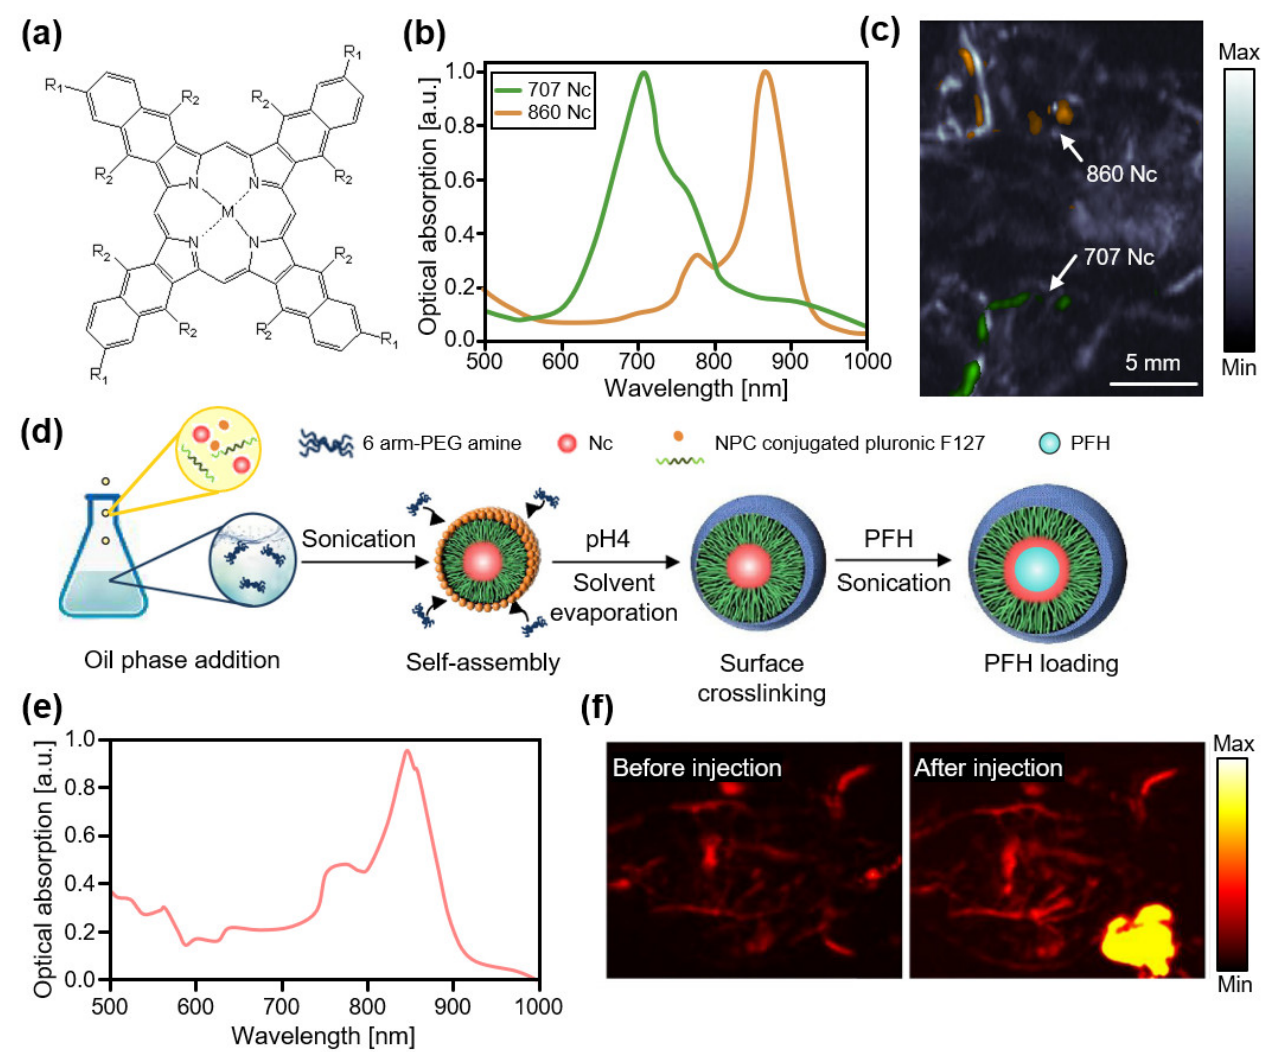
Figure 4. Contrast-enhanced PA images of Nc-based agents in the high NIR-I region. ( a ) Chemical structure of nanoformulated Nc dyes. 707 Nc is formulated with M = Zn, R 1 = t-Bu, and R 2 = H, while 860 Nc is formulated with M = 2H, R 1 = H, and R 2 = O-(CH 2 ) 3 CH 3 . ( b ) Optical absorption spectra of two different nanoformulated Nc dyes. ( c ) Contrast-enhanced PA images of lymphatic networks in mice after injection of the nanoformulated Nc dyes into the right and left forepaws. Green and orange colors indicate PA signals from the nanoformulated Nc dyes, with a peak absorption at 707 and 860 nm, respectively. Reprinted with permission from Ref. [98]. 2015, Elsevier. ( d ) Schematic illustration for the synthesis of Nc encapsulated PFH. ( e ) Optical absorption spectrum of the encapsulated Nc dyes with PFH. ( f ) Contrast-enhanced PA images before and after injection of the encapsulated Nc dyes into mice. PA, photoacoustic; Nc, naphthalocyanine; NIR, near-infrared; PFH, perfluorohexane; NPC, 4-nitrophenyl chloroformate. Reprinted with permission from Ref. [100]. 2019, ACS Publications.